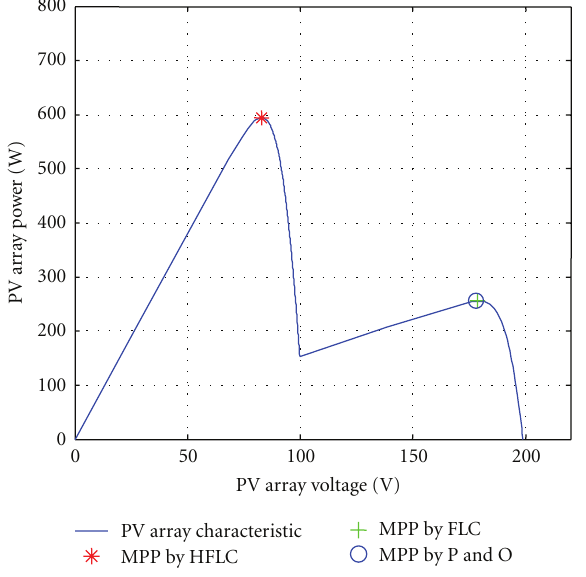
Figure 28: MPP under partial shading 600 W/m 2 and 1000 W/m 2